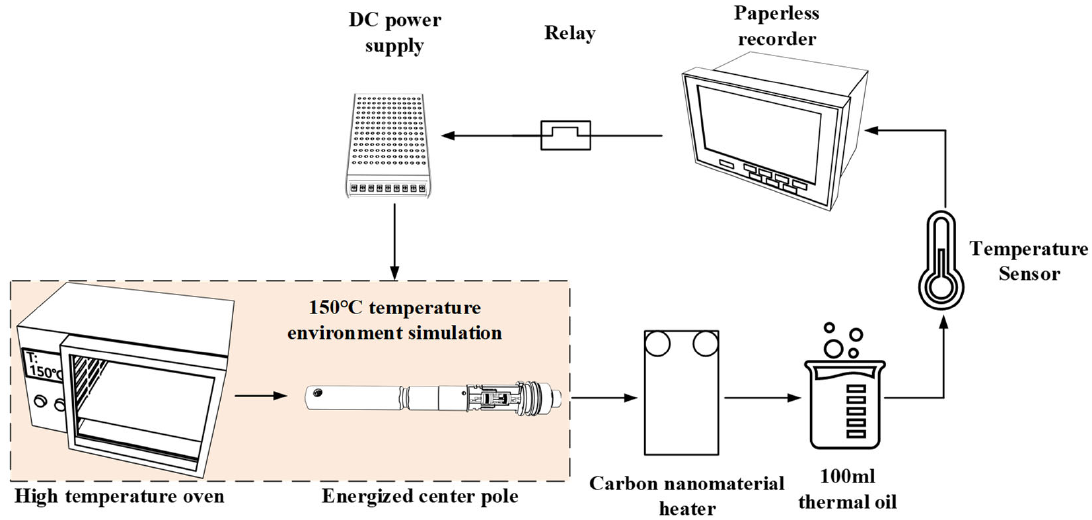
Figure 25. High-temperature test experiment of the conductive center pole. The physical experiment platform is shown in Figure 26.